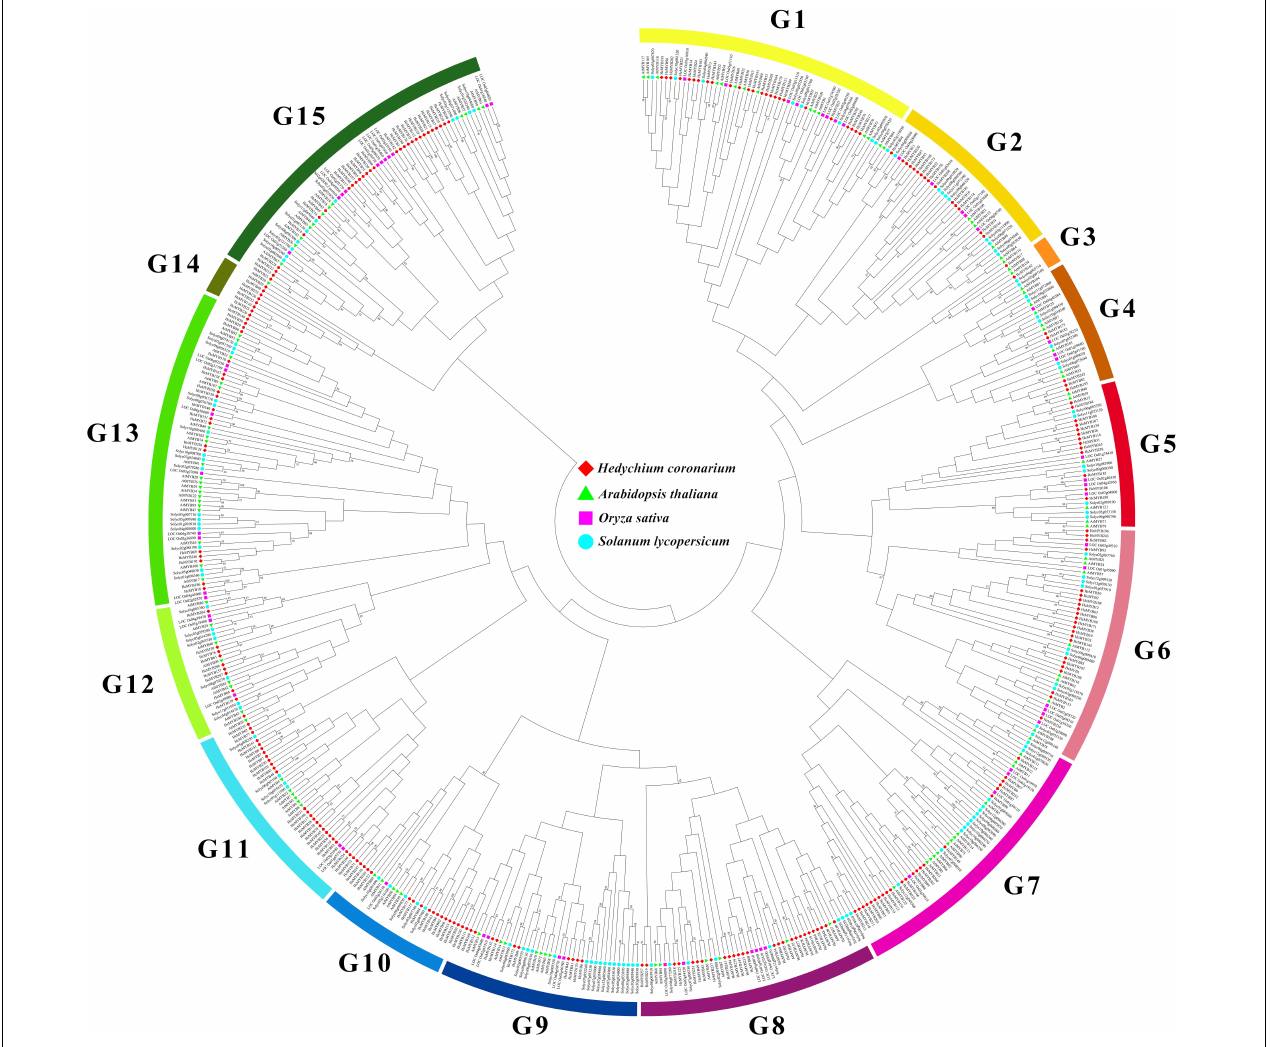
FIGURE 1 | Phylogenetic analysis of MYB proteins among H. coronarium , Arabidopsis , tomato, and rice. Full-length amino acid sequences were aligned using ClustalX 2.1 program and unrooted NJ phylogenetic tree was generated using MEGA X with 1,000 bootstrap values. The bootstrap values of less than 50 were omitted. All MYB proteins are clustered into 15 subgroups (G1–G15) indicated by different